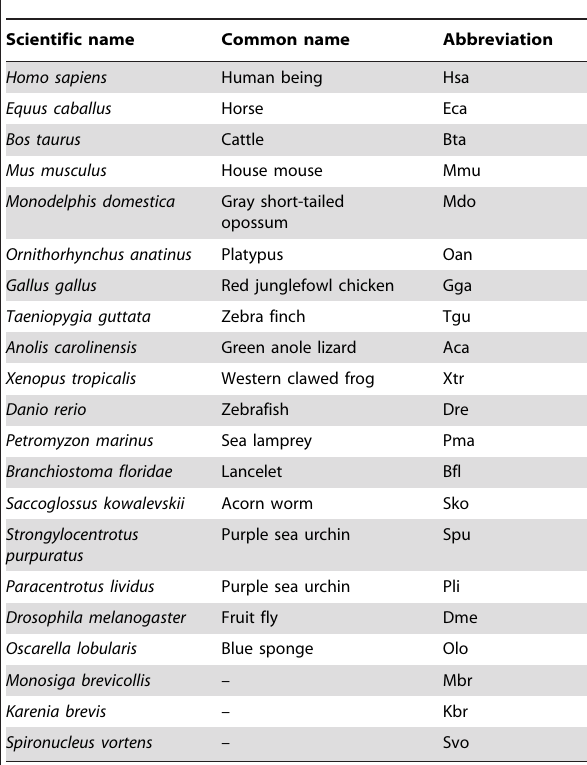
Table 1. Scientific names, common names and three letter code abbreviations used for the 21 organisms considered in the